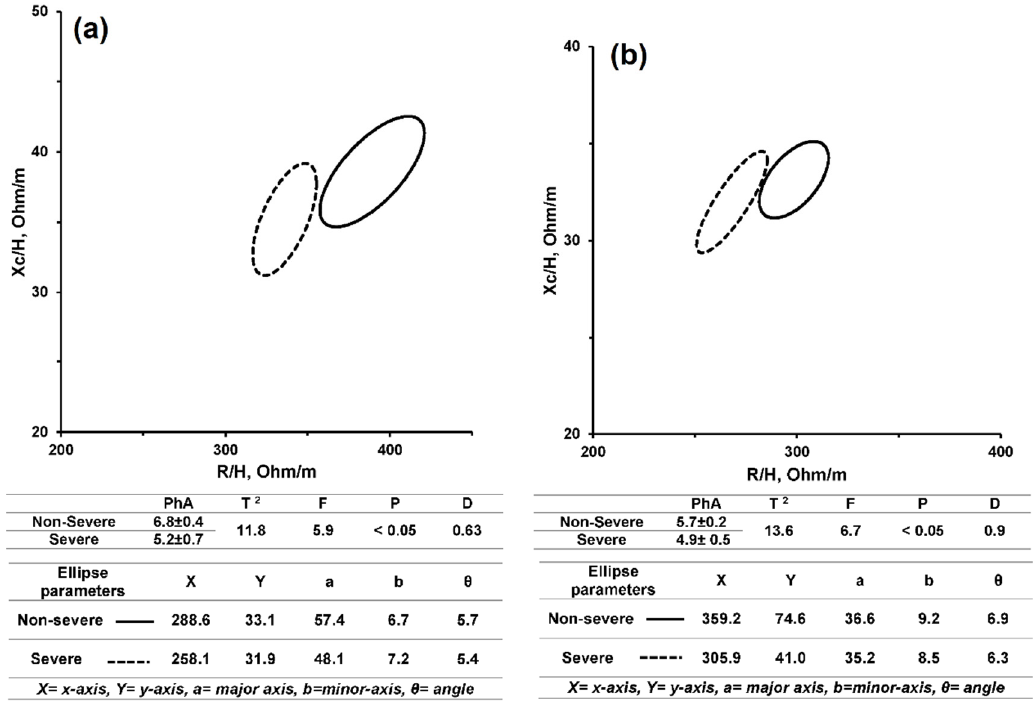
Figure 3. The 95% confidence ellipses for non-severe (solid) and severe Dengue-infected (dashed) subjects: ( a ) Males; ( b ) Females.